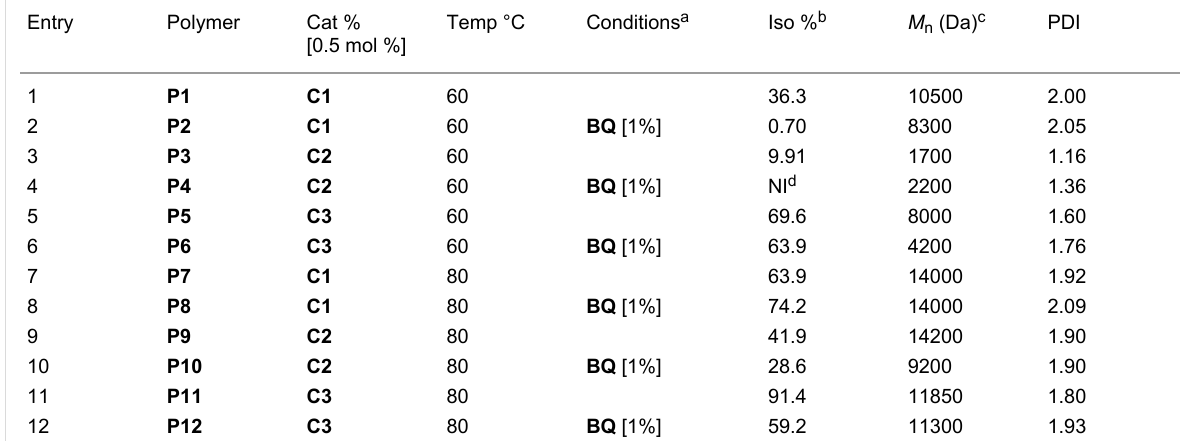
Table 1: Overview of polymerization and the isomerization results of the corresponding polymers obtained at 60 and 80 °C after 5 h reaction time. Entry